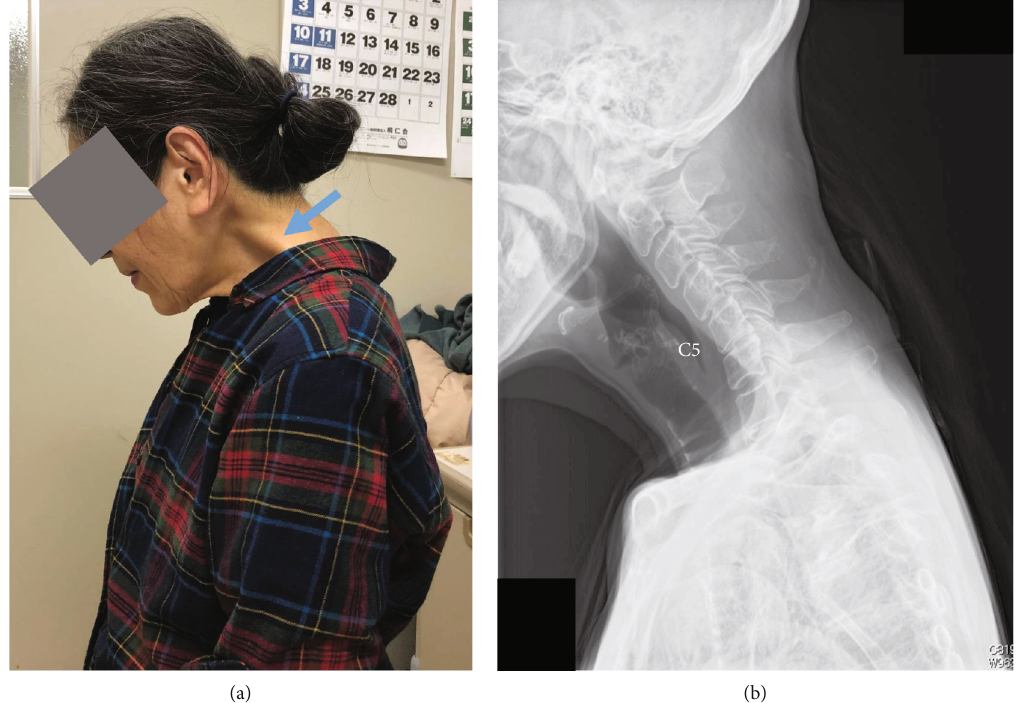
Figure 1: Lateral view of the patient ’ s neck (a) and her cervical lateral radiograph (b) at the fi rst visit. (a) Dropped head syndrome (DHS) was evident. Remarkable bulging was seen over her trapezius and levator scapulae muscles (a, arrow). (b) The patient ’ s cervical spine inclined forward, and kyphotic deformity was present at